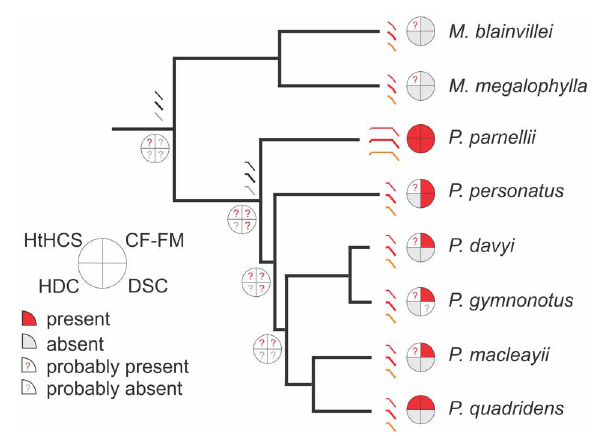
FIGURE 4 | Echolocation traits of mormoopid bats mapped onto the molecular phylogenetic tree of the family, after Van den Bussche and Weyandt (2003) and Dávalos (2006). Schematics of echolocation calls from extant species (in red) and suggested common ancestors (in gray) have been represented. The heteroharmonic computation strategy is expected to be found in each species of the family, in contrast to the other three traits that characterize only some of the extant species. The evolutionary position of P. parnellii points to the long-CF calls and HDC as evolutionary